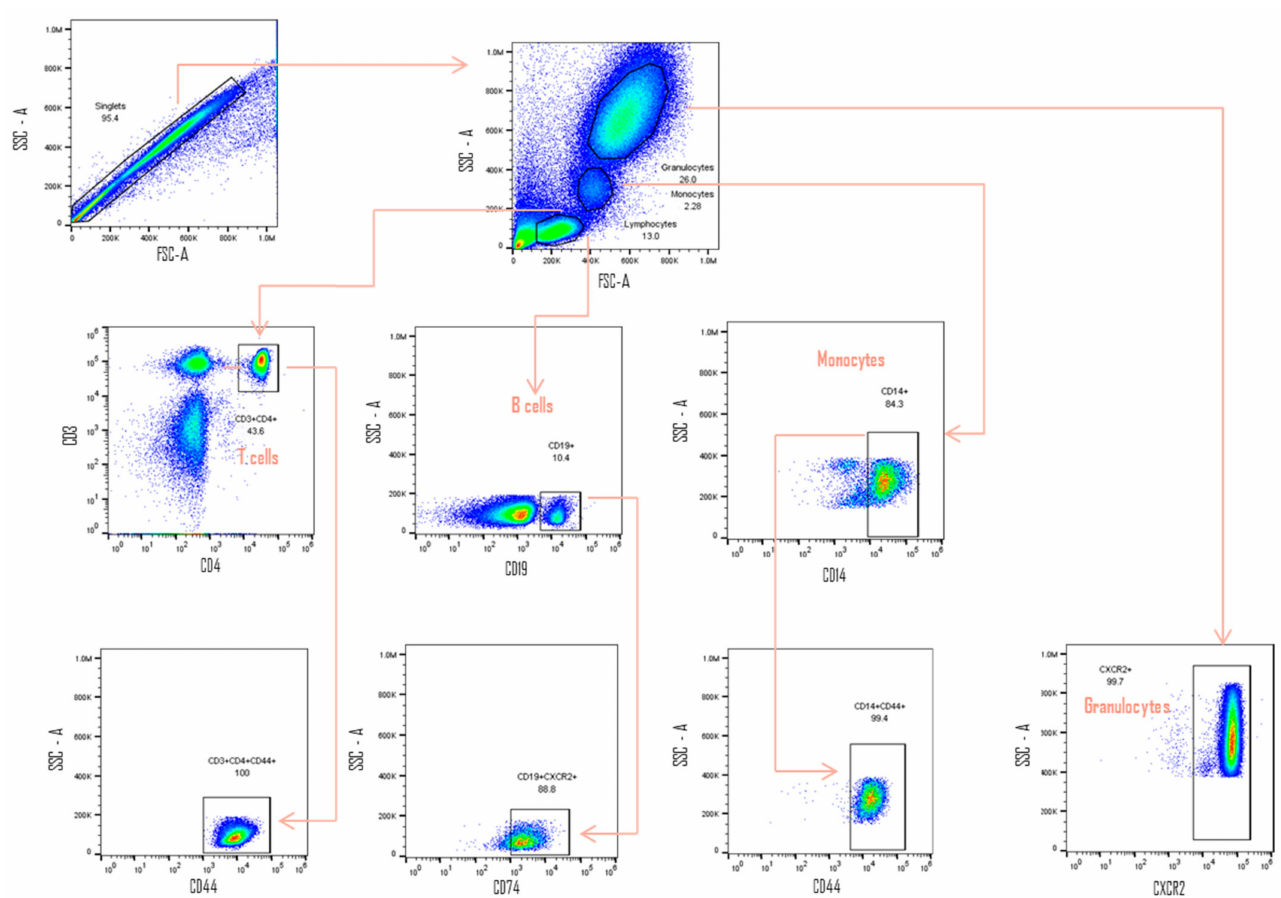
Figure 1. Gating Strategy. Overlapping events were ruled out from the FSC-H/FSC-A analysis. Subsequently, the populations were selected by size and complexity. From the lymphocyte region, T lymphocytes were identified as CD3 + and CD4 + cells, and CD19+ for B lymphocytes. Monocytes were identified as CD14+ cells. Once the three populations had been selected, the positive cells for CD74, CD44, CXCR2, CXCR4 and CXCR7 receptors were identified from the pre-established FMOs (CD44 are represented in CD4+ T lymphocytes, CD74 in B lymphocytes, CD44 in monocytes and CXCR2 in granulocytes). FSC-H/FSC-A; FSC-Height (FSC-H) by FSC-Area (FSC-A). FMO; Fluoresence minus